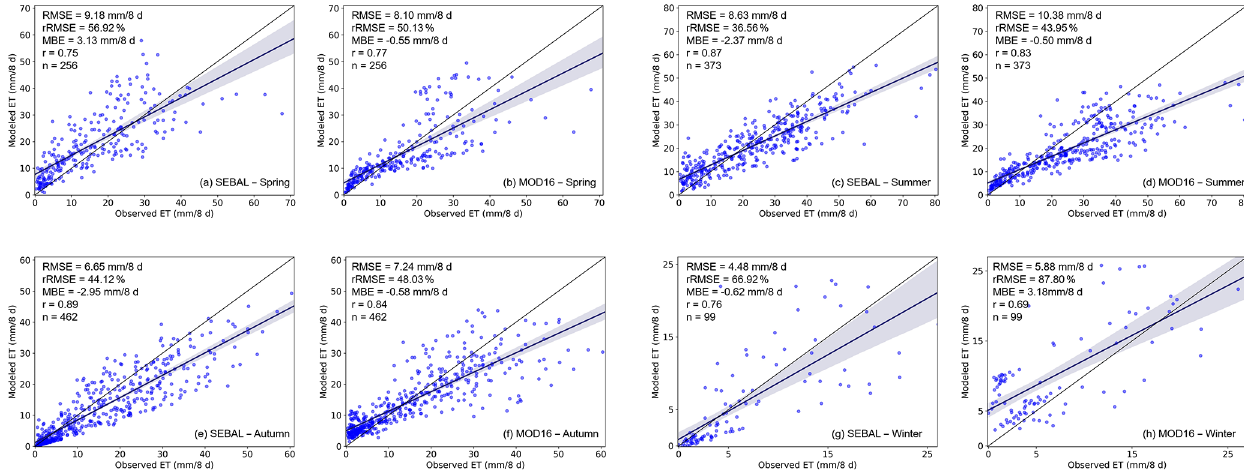
Figure 8. Validation for different seasons. (a) SEBAL ET for spring; (b) MOD16 ET for spring; (c) SEBAL ET for summer; (d) MOD16 ET for summer; (e) SEBAL ET for autumn; (f) MOD16 ET for autumn; (g) SEBAL ET for winter; (h) MOD16 ET for